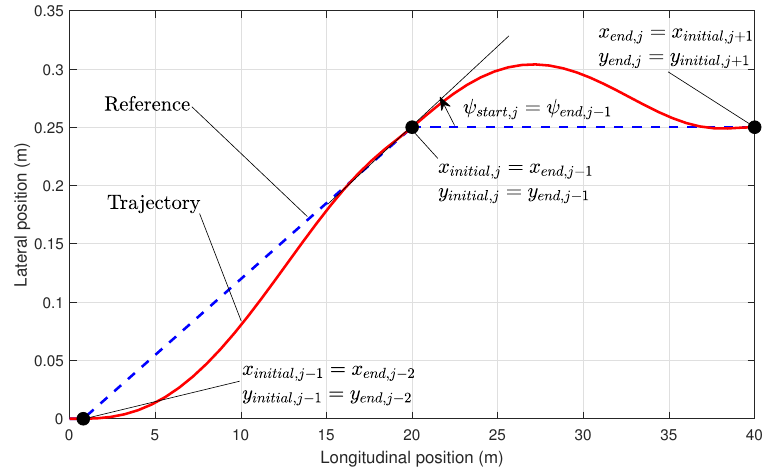
Figure 1. Trajectories between three